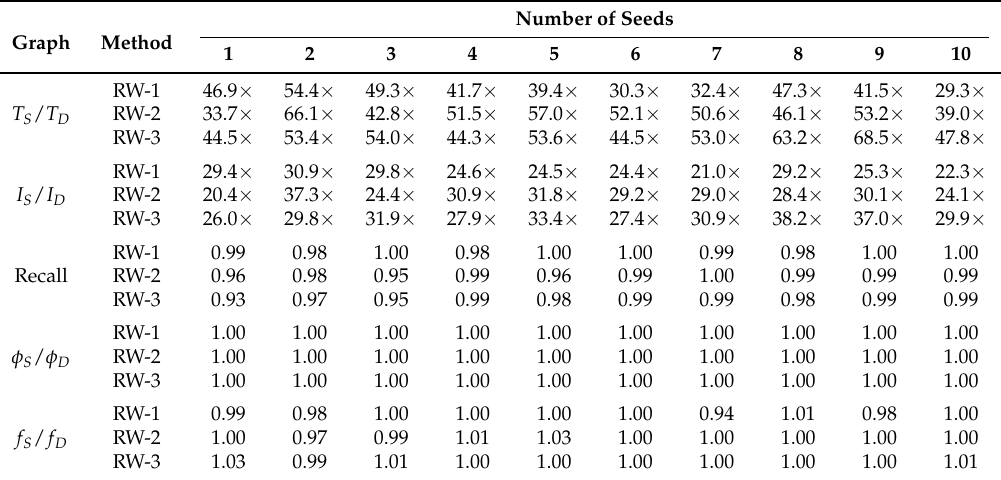
Table 6. Results for different seeding methods. Columns are graph name, seeding method, speedup in time, speedup in iterations, recall, ratio of conductance scores, and ratio of normalized edge cut scores. Results shown are averaged over all